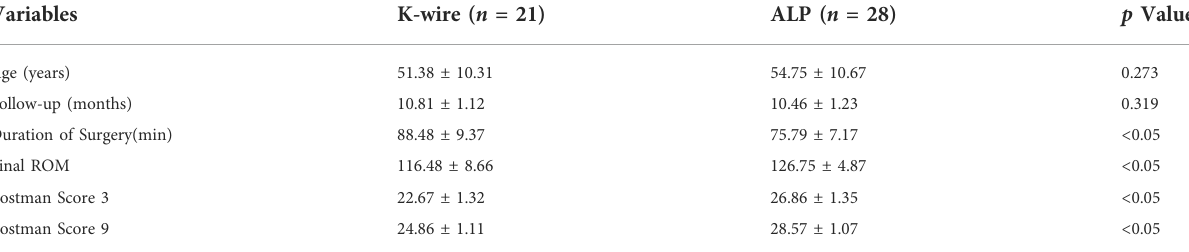
TABLE 3 Comparisons of Kirschner-wire tension band combined with patellar cerclage (K-wire) to ALP (ALP) techniques for inferior pole patellar fracture (mean ± SD). Variables K-wire ( n = 21) ALP ( n = 28)